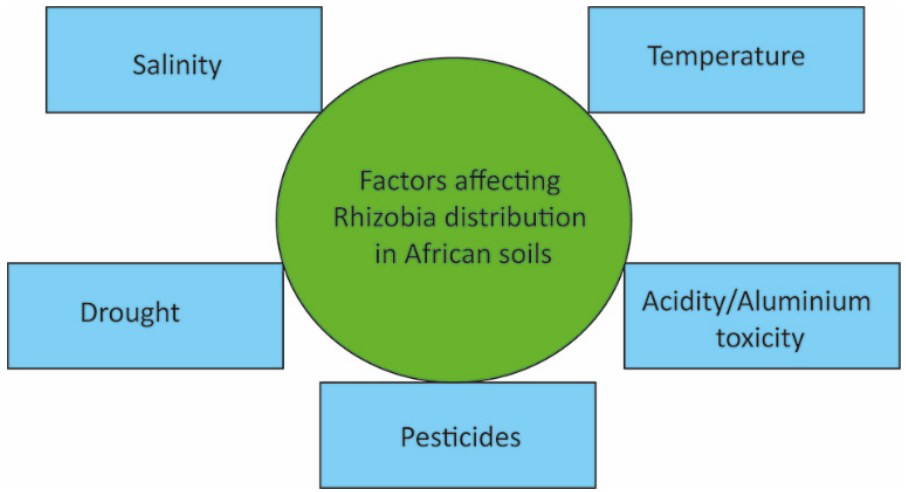
Figure 3. Factors affecting the distribution of rhizobia in African soils.